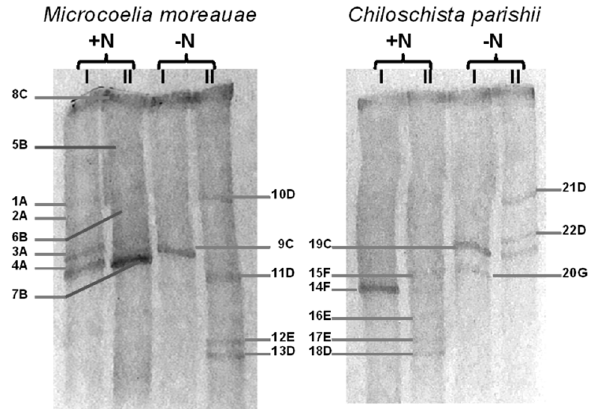
Figure 3. DGGE profile of cyanobacterial community of the roots of leafless orchids Microcoelia moreauae and Chiloschista parishii , obtained with CYA359F–CYA781Rb (I) and CYA359F–CYA781R а